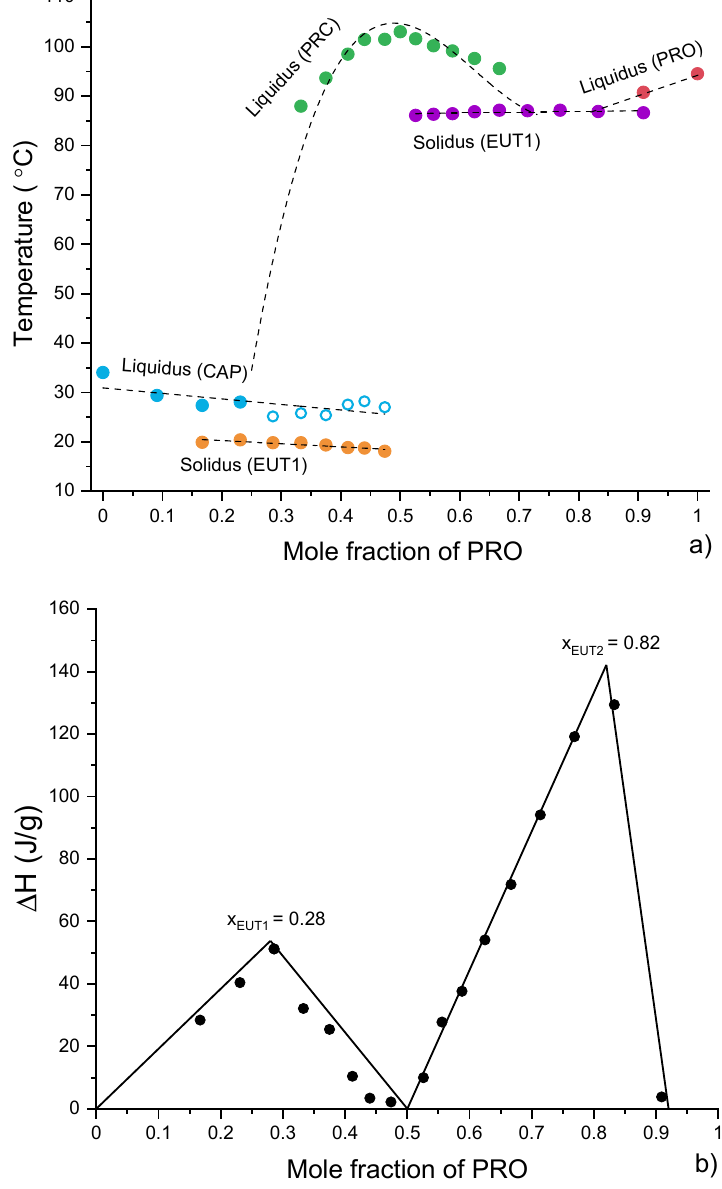
Figure 10. ( a ) Phase diagram constructed using thermal data obtained from the first heating of physical mixtures (CAP-PRC and PRO-PRC). Open symbols indicate uncertainty in identifying the phase. The lines are used as a guide for the eye. ( b ) Tammann plots constructed using thermal data obtained from the first heating of physical mixtures (CAP-PRC and PRO-PRC). The lines are best fits to the data